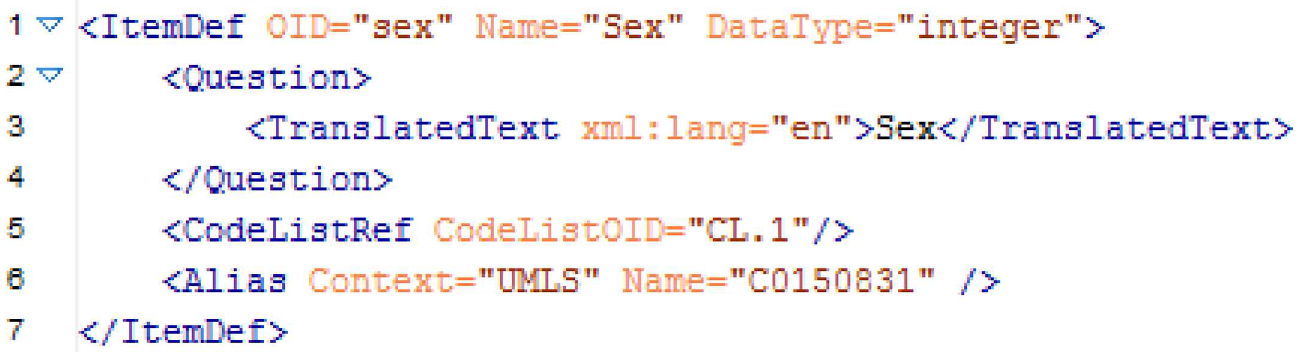
Fig 1. An exemplary item definition for the item sex in ODM format.